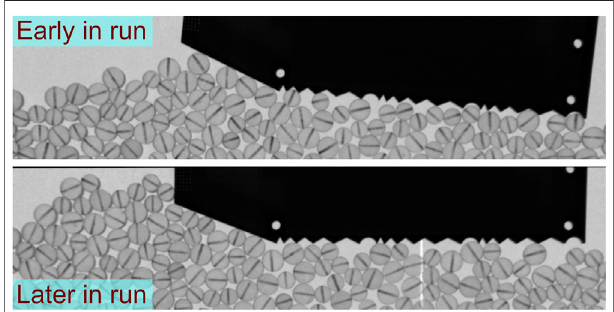
Frontiers in Physics |